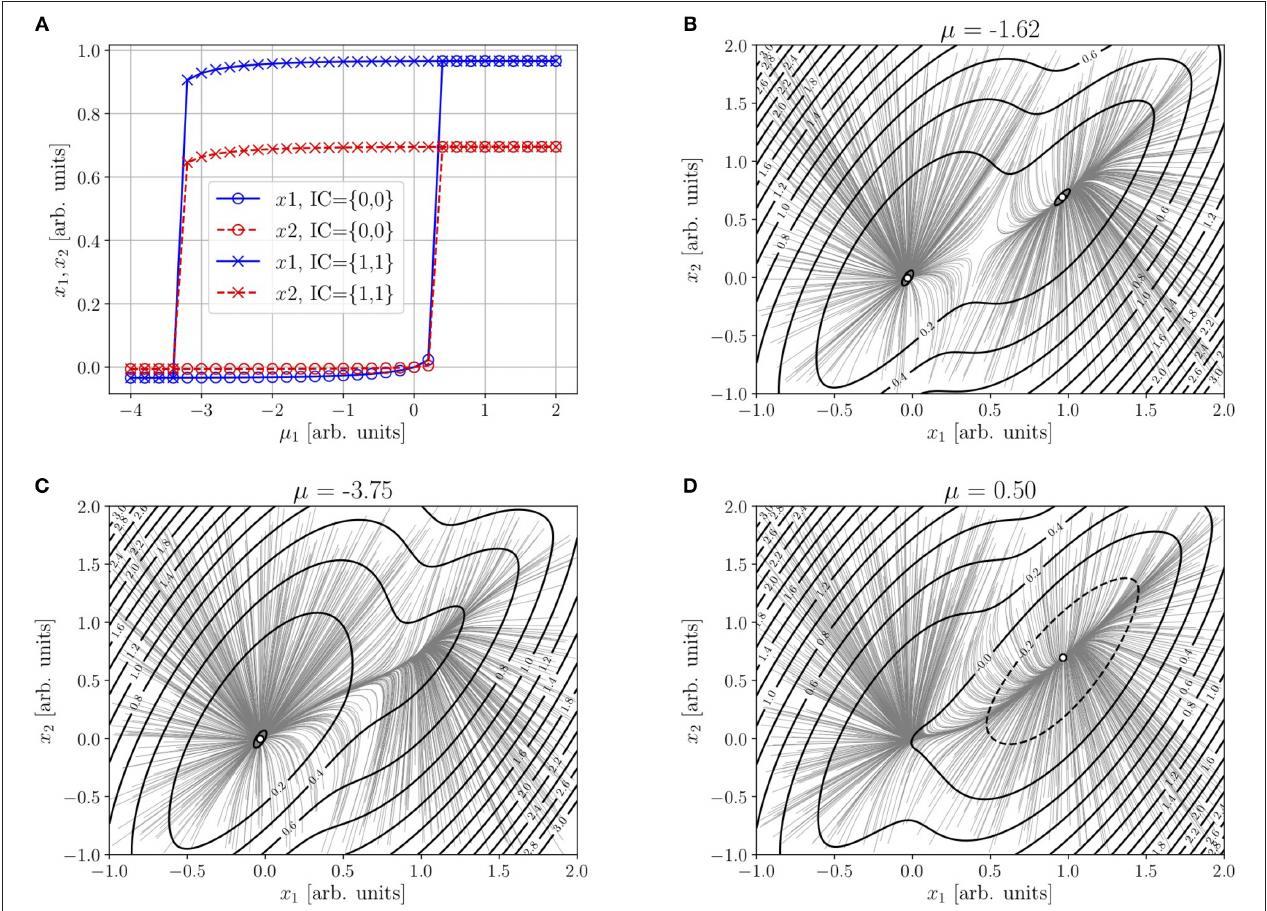
r 2 0) as functions of µ 1 . = = S k ( µ k ) given by Equation (12)—near the equistable case − τ 2 ν 2 1, τ 1 1, ν 1 1, µ 2 0, j 11 12, j 12 4, = = = = = = = =